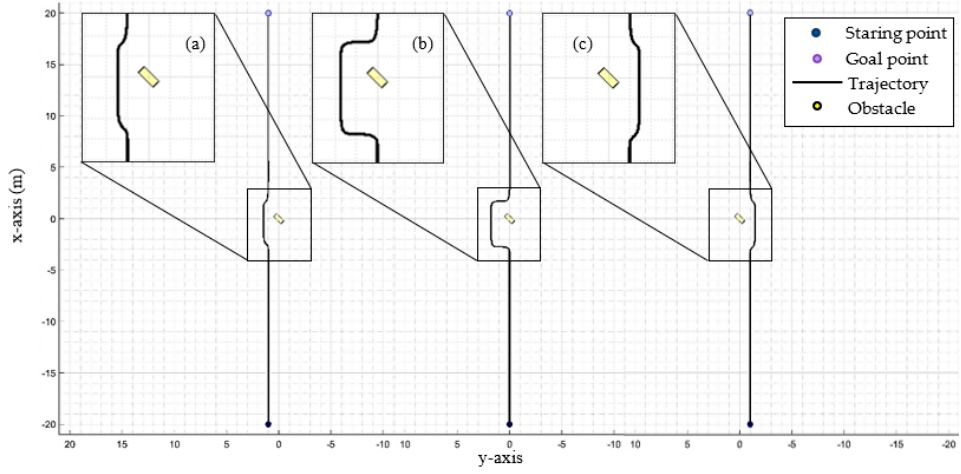
Figure 13. Flight trajectory of three cases avoidance. ( a ) Left case, ( b ) middle case, ( c ) right case.